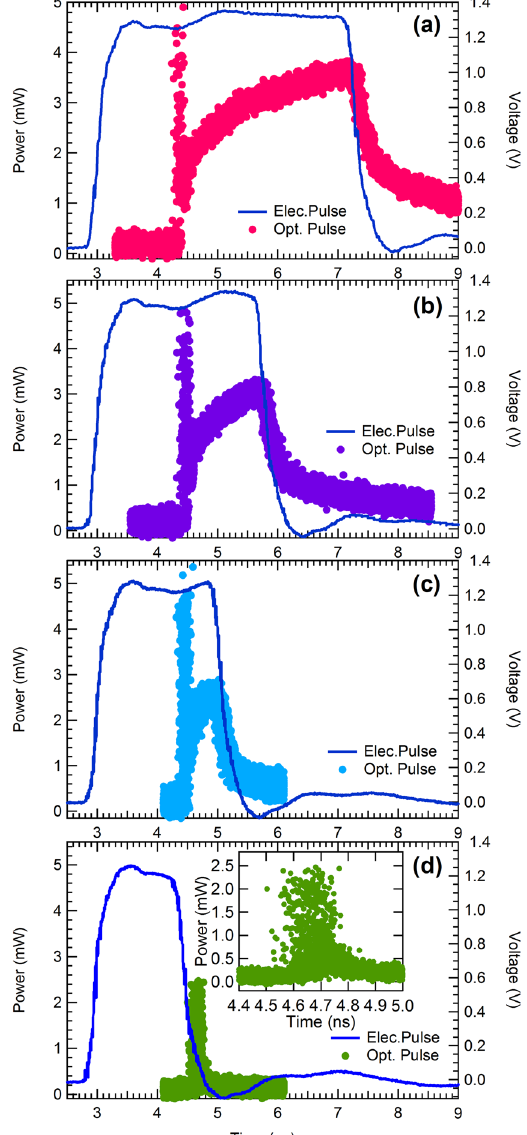
Figure 4. Waveforms of the optical output of the laser diode generated due to the application of electrical pulses with different durations. ( a ) Waveforms of the driving electrical pulse with a duration of 4.3 ns and the corresponding optical pulse with a duration of 3.0 ns. ( b ) Waveforms of the driving electrical pulse with a duration of 2.7 ns and the corresponding optical pulse with a duration of 1.3 ns. ( c ) Waveforms of the driving electrical pulse with a duration of 2.0 ns and the corresponding optical pulse with a duration of 0.7 ns. ( d ) Waveforms of the driving electrical pulse with a duration of 1.7 ns and the corresponding optical pulse with a duration of 0.3 ns. ( e ) Waveforms of the driving electrical pulse with a duration of 1.4 ns and the corresponding optical pulse with a duration of around 100 ps. Inset shows an enlarged figure of the waveform of the optical